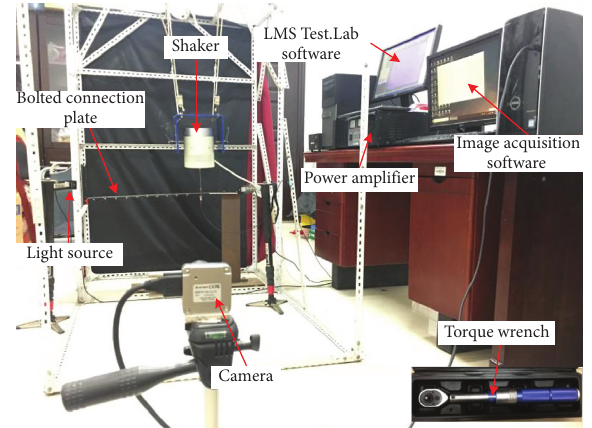
Figure 4: Experimental